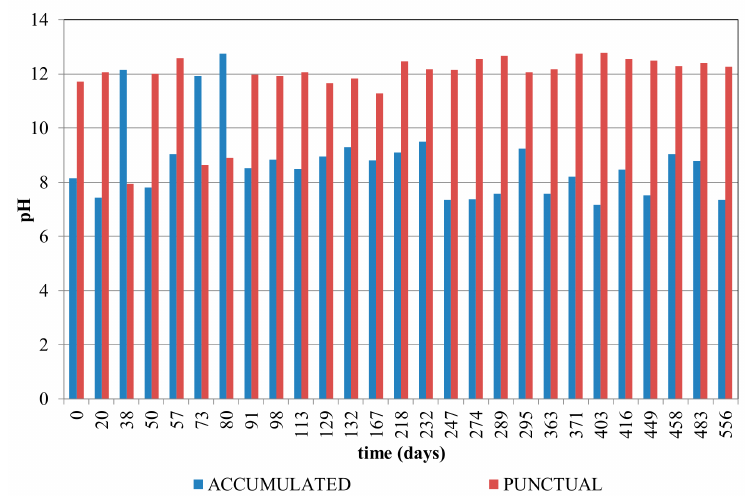
Figure 7. pH results obtained from the leachates of the “accumulated” ( blue ) and “punctual” ( red ) rainwater